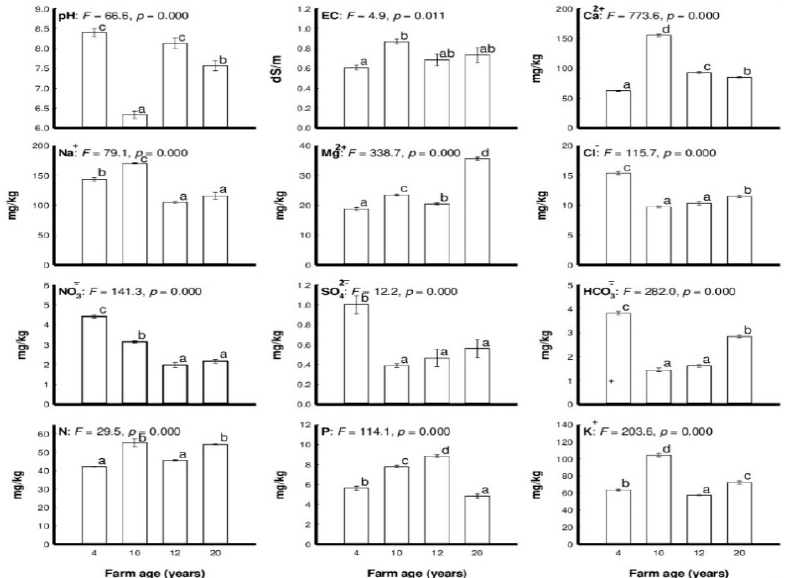
Figure 1. Mean soil characteristics of the four sampling farms in the mountainous area of Taif City in Saudi Arabia, supporting the growth of the Taif rose populations. The standard errors of the means ( n = 6) are indicated by vertical bars. F -values demonstrate the one-way analysis of variance (ANOVA), with degrees of freedom ( df ) = 3. Means followed by different letters are significantly different at p < 0.05, according to Tukey’s HSD test.